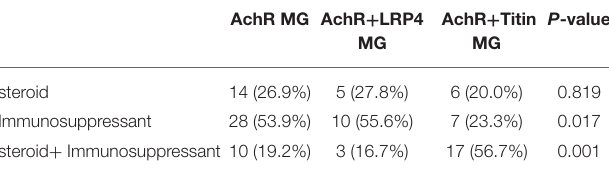
TABLE 3 | Therapeutic strategy for MMS or better among three